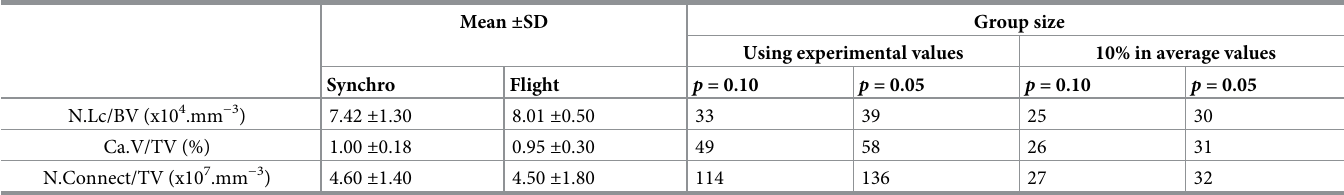
Table 3. Theoretical group size required to measure porosity network variations in the present study. Averages over the four quadrants were used for this calculation but little variations are observed when considering one given anatomical region. Mean ± SD Group size Using experimental values 10% in average values Synchro Flight p = 0.10 p = 0.05 p =